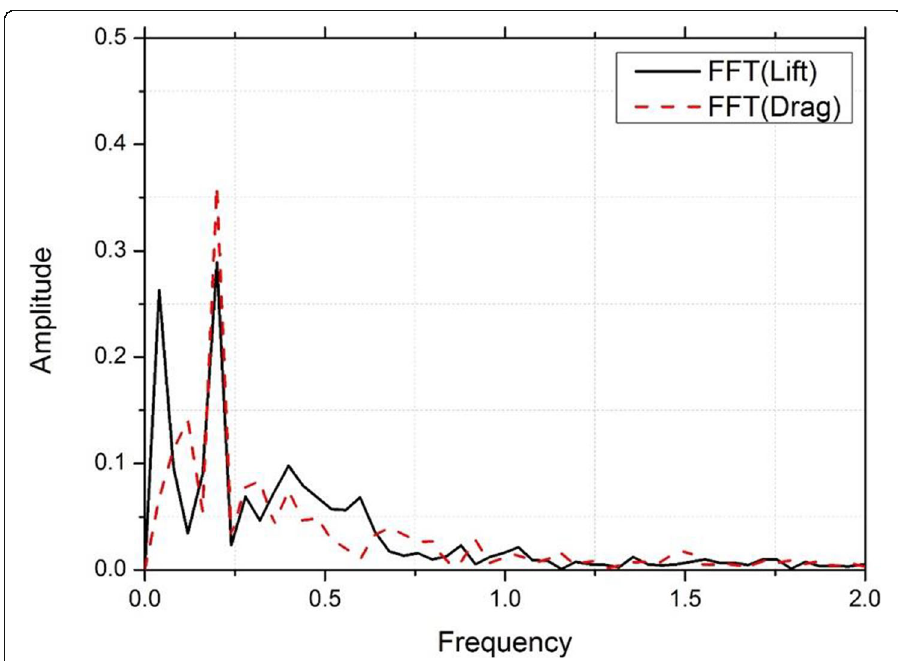
Fig. 9 Spectral analysis of local force coefficients for rotating Magnus rotor with AR = 3